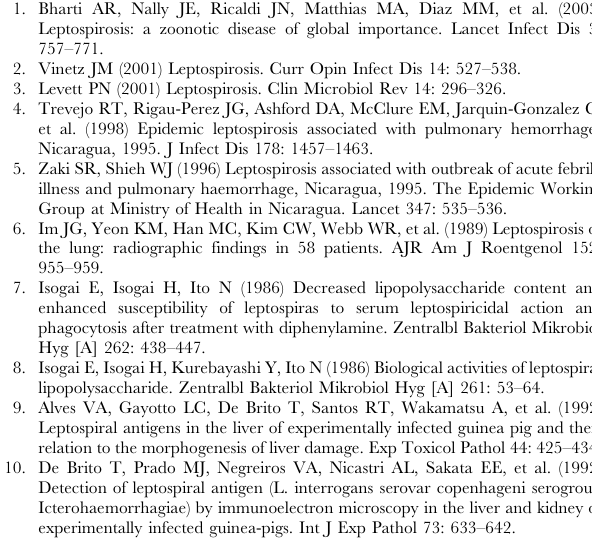
Figure S5 Time-course of L-PAF-AH in the sera of gerbils injected with the virulent strain. The measurements were performed on the 2nd, 3rd, 4th, 5th, 6th, 7th, 8th and 9th days via both ELISA and immunoprecipation followed by mass spectrometric identification. The EMJH culture supernatant of leptospira obtained in the later stationary phase was used as the positive controls. X , L-PAF-AH detected by ELISA; e , L-PAF- AH undetectable by ELISA; w , L-PAF-AH detected by immunoprecipation followed by mass spectrometry; q , L-PAF- AH undetectable by immunoprecipation followed by mass spectrometry. The standard error of the experiments was indicated by bars. Figure S6 PAF-AH levels in serum from the 1st to 9th day in gerbils with experimentally infected leptospirosis and in healthy gerbils. PBS (n= 107), injected with PBS alone; avirulent (n= 106), injected with the avirulent strain of L. interrogans serovar Lai; virulent (Total) (n= 136), injected with L. interrogans serovar Lai, including the serum of the gerbils which were dying and 5 hr before dying; virulent (Dying) (n = 56), injected with PBS with L. interrogans serovar Lai, and collected from the gerbils which were dying and 1 hr before dying. Horizontal bars represented the mean value for each group. Found at: doi:10.1371/journal.pone.0004181.s006 (0.23 MB